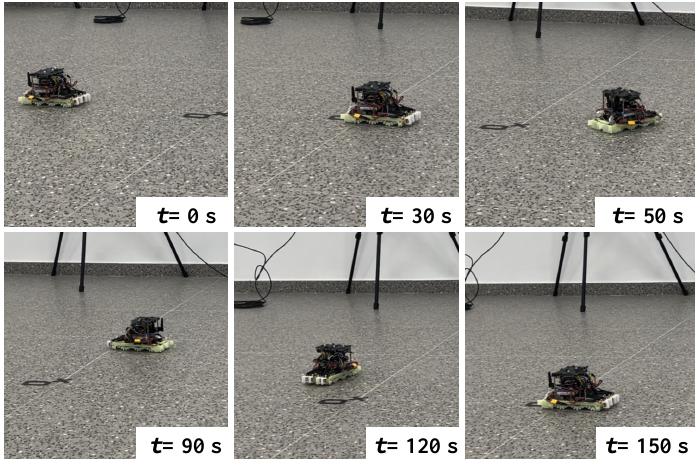
Figure 8. The screenshots of the experimental